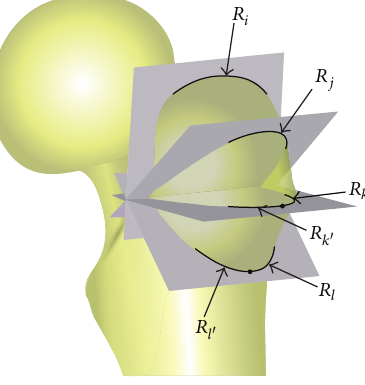
Figure 2: Diagram of four planes established, which were virtual cross sections and included the points 𝑖 , 𝑗 , 𝑘 , and 𝑙 , respectively. The radius of the intersected curve between each plane and the greater trochanter was then measured to evaluate the shape of the greater trochanter. Each radius measured is shown ( 𝑅 𝑖 , 𝑅 𝑗 , 𝑅 𝑘 , 𝑅 𝑘 󸀠 , 𝑅 𝑙 , and 𝑅 𝑙 󸀠 ).